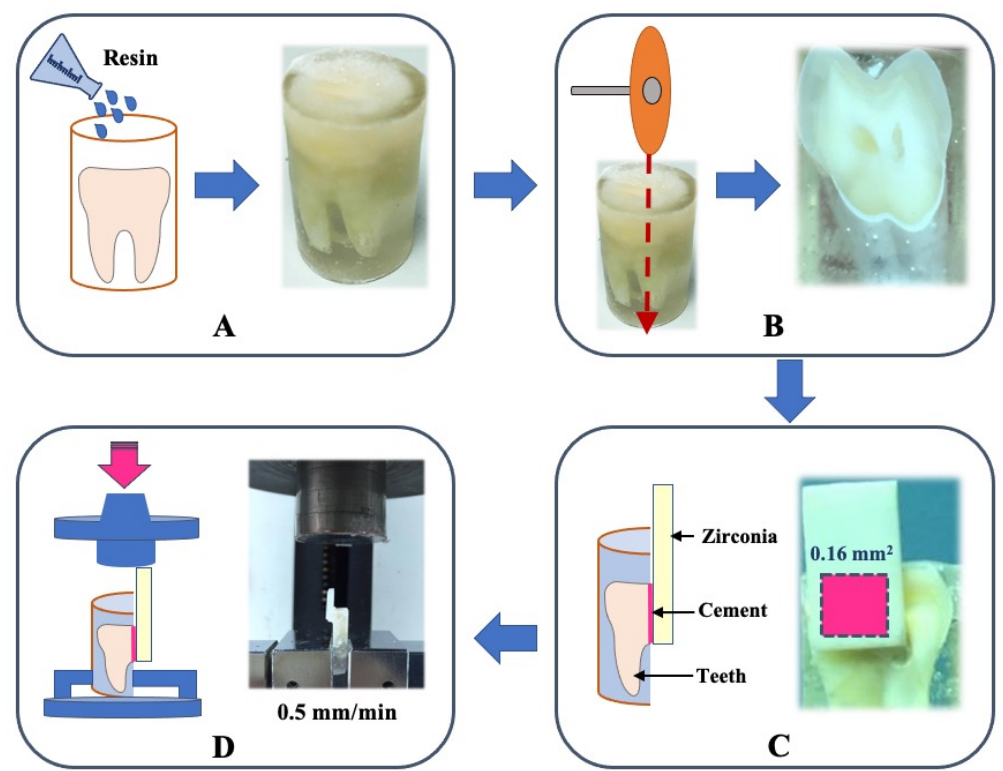
Figure 2. Compendium illustration showing the bonding of zirconia samples to teeth for the strength tester. ( A ) Embed; ( B ) Cut; ( C ) Bonding; ( D ) Strength tester.